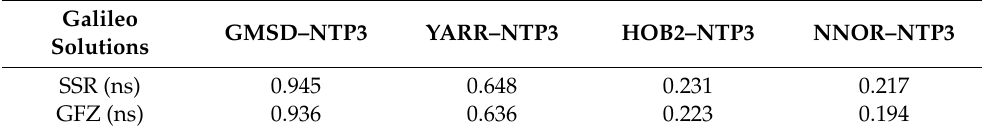
Table 7. RMS of Galileo results for the time links (ns).